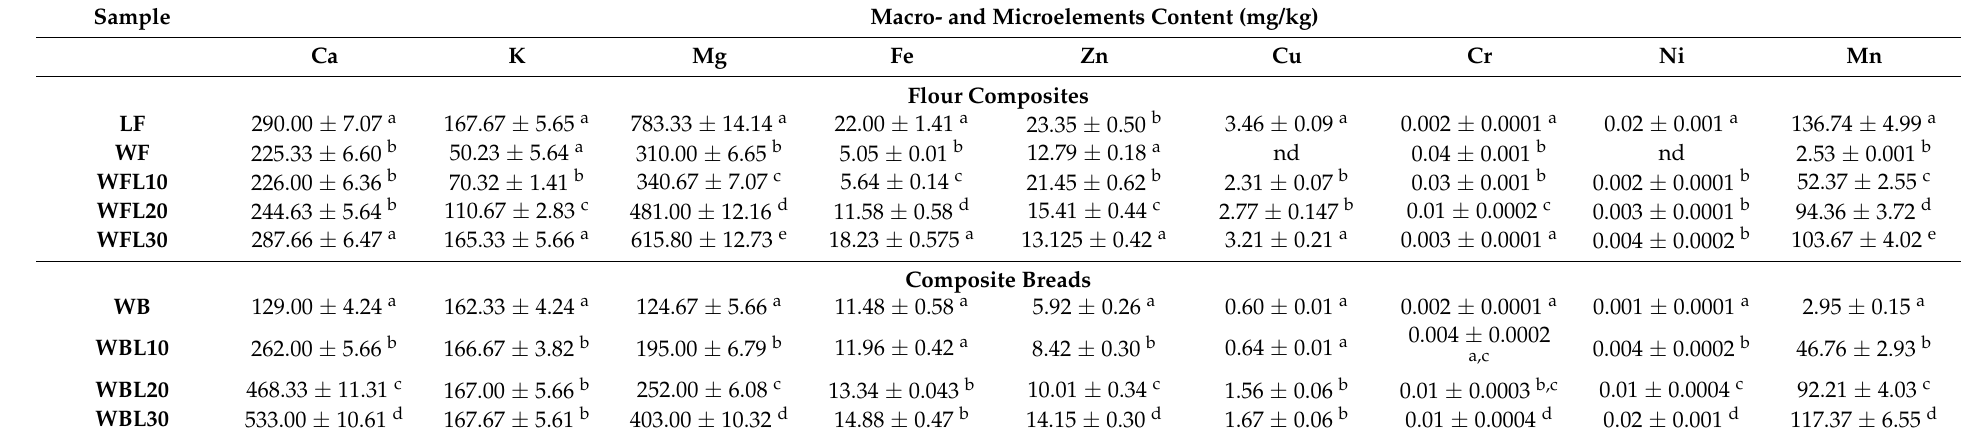
Table 4. Macro and microelements content of lupin flour composites and